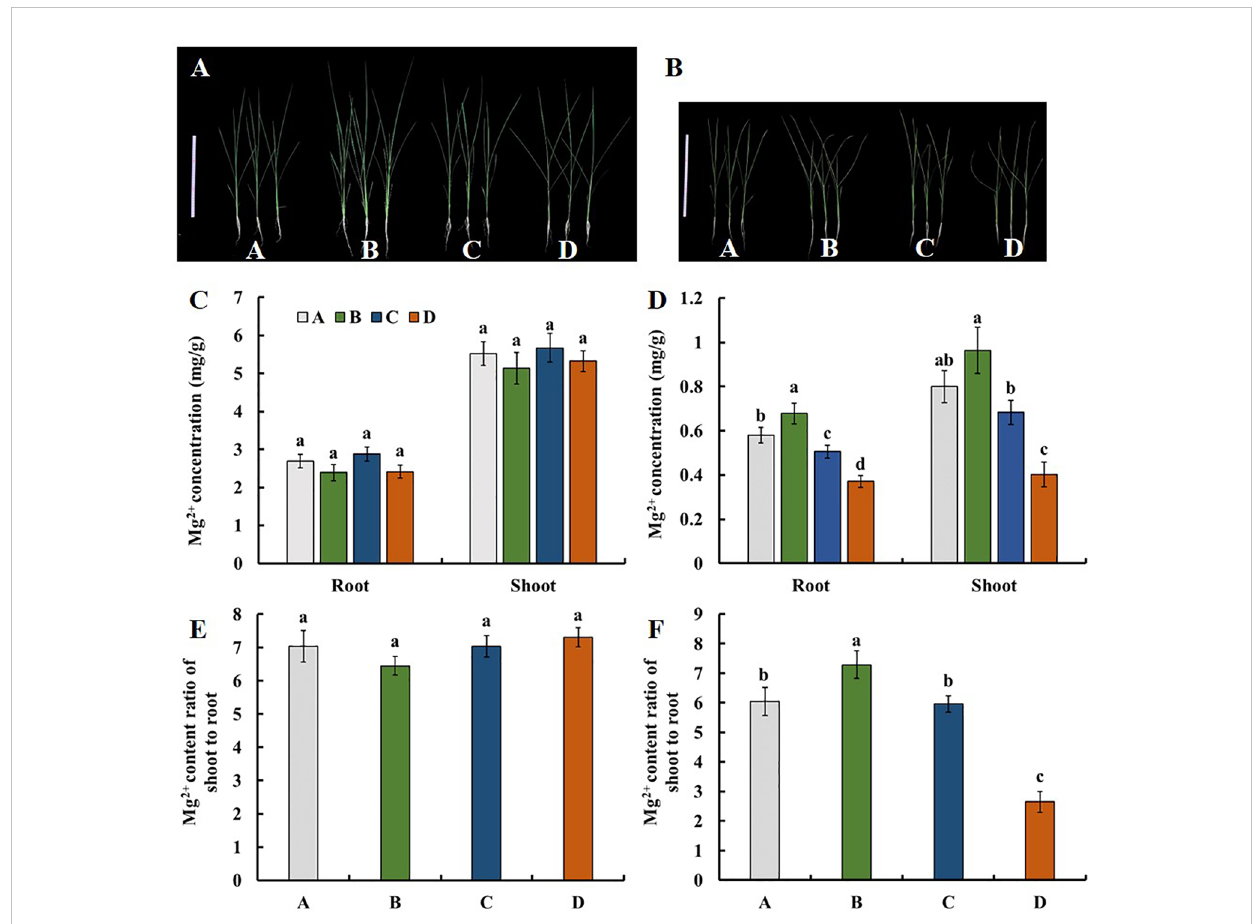
FIGURE 1 Mg 2+ uptake and translocation of the four parental lines of the DC1 population. Rice seedlings cultured in the 1/4 strength IRRI solution for two weeks, and in the full strength IRRI solution with (A) 1 mM Mg 2+ or (B) without Mg 2+ for three weeks. Bar: 30 cm. The Mg 2+ concentration of seedlings treated with (C) 1 mM Mg 2+ or (D) without Mg 2+ . The shoot-to-root ratio of the Mg 2+ content (Mg 2+ translocation) of seedlings treated with (E) 1 mM Mg 2+ or (F) without Mg 2+ . Values are mean ± SE ( n = 4). The different letters above the bars indicate a signi fi cant difference between each line ( P <